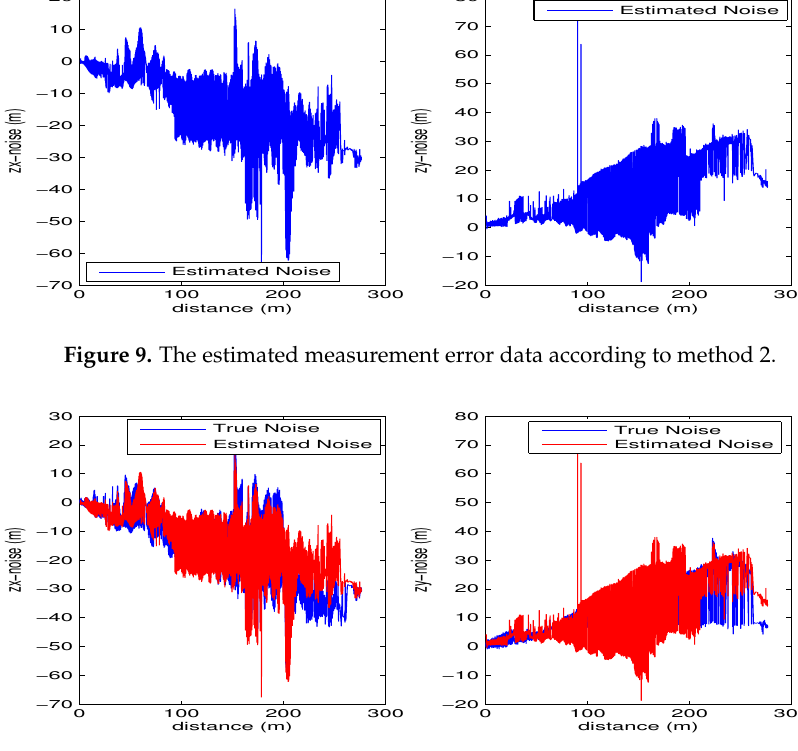
Figure 10. The comparison of true and estimated measurement error